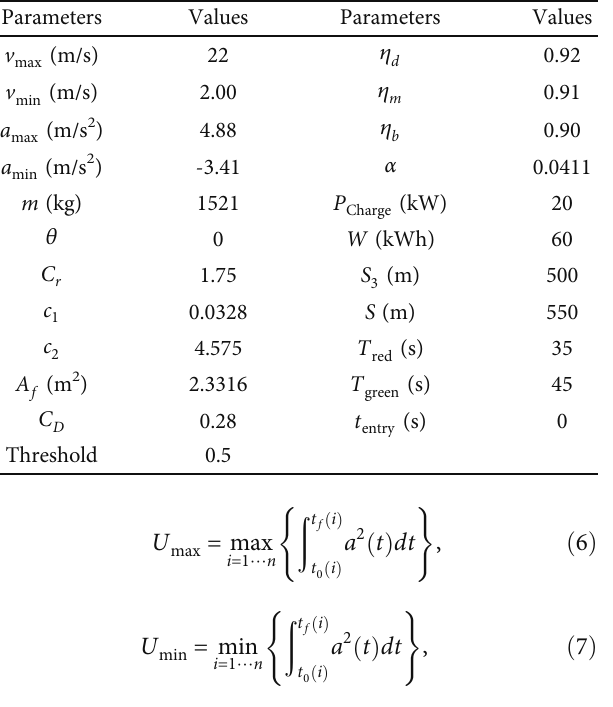
Table 3: Parameters used in